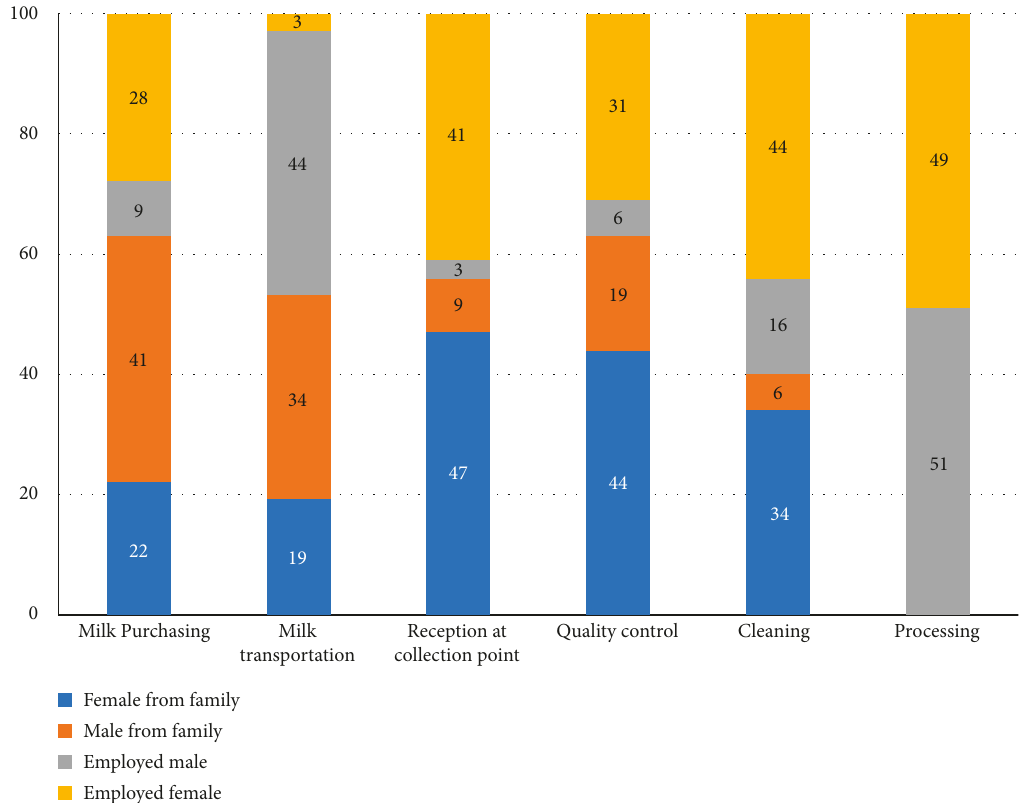
Figure 6: Gender involvement in the downstream dairy value chain (percentage).